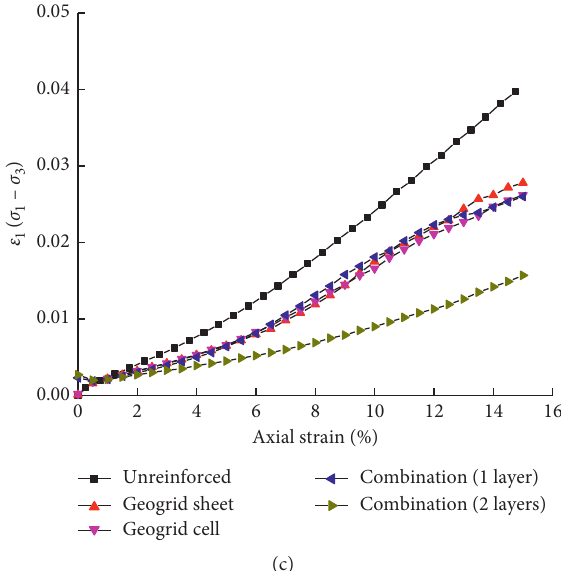
Figure 6: ε − σ ) − ε / ( σ curves of sand under different confining pressures: (a) σ 3 � 50 kPa, (b) σ 3 � 75kPa, and (c) σ 3 � 1 1 3 1